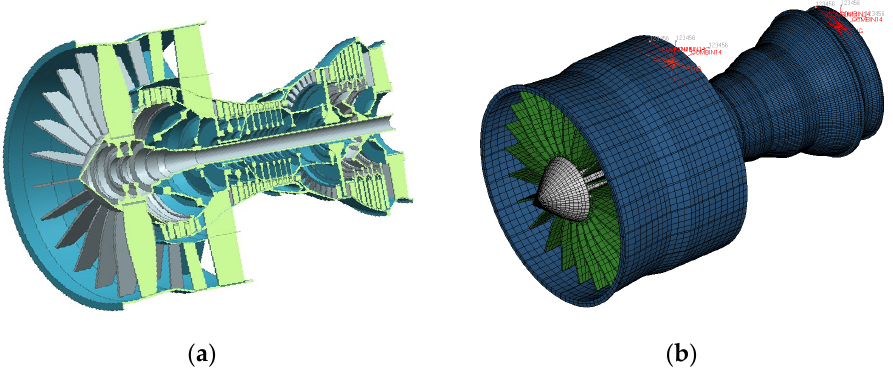
Figure 4. Geometry and finite element model of a double-rotor turbofan engine with a large bypass ratio. ( a ) Half-sectional view of the geometry model; ( b ) Finite element model.